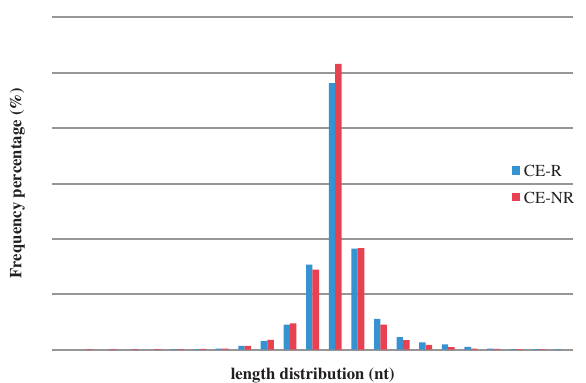
Figure 1. The size distribution of the small RNAs in CE-R and CE-NR libraries. (CE-R: sheep with CE-resistant (R) haplotype; CE-NR: sheep with CE-non-resistant (NR) haplotype).